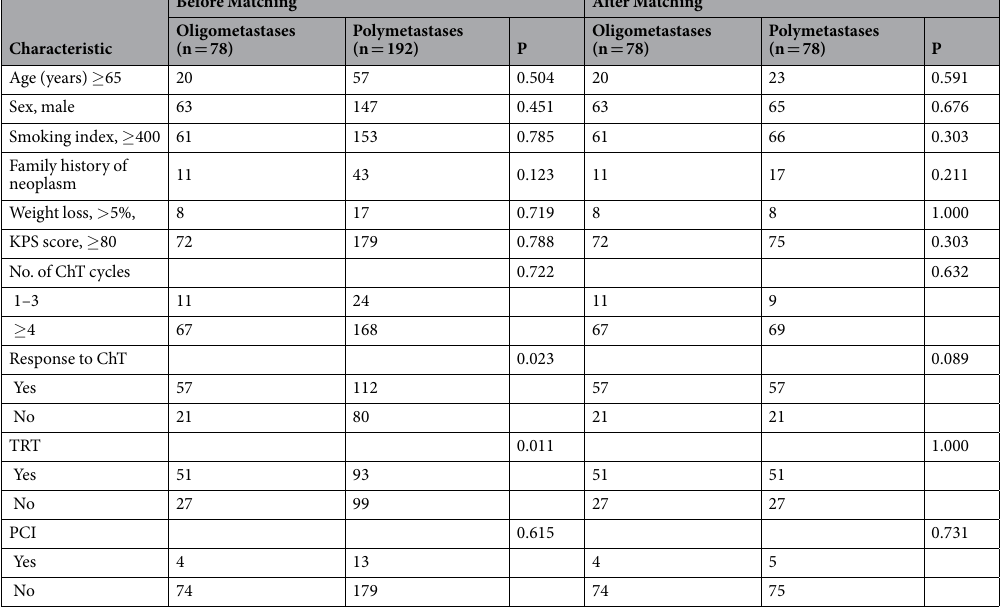
Table 2. Disease characteristics of patients with oligometastases vs. polymetastases after Propensity Score Matching.